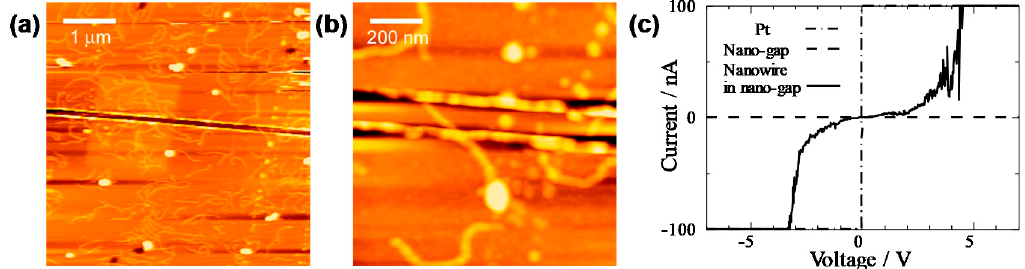
Figure 5. ( a ) AFM images of nanowires in the nanogap. ( b ) is an enlarged view of ( a ). ( c ) Current-voltage (I-V) characteristics of PMPS based nanowires between nanogap electrodes. The nanowires were formed by 500 MeV Au ion irradiation to polysilane thin film of 400 nm thickness. The fluence of ions was 1.0 × 10 9 cm − 2 . Reproduced with permission from ref. [93] © 2004, The Japan Society of Applied Physics.